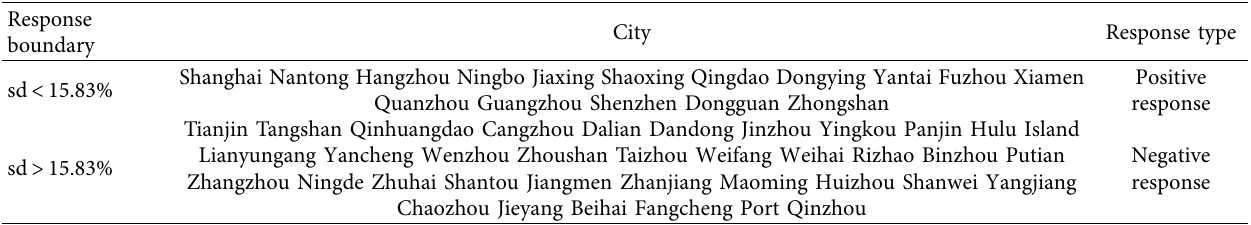
Table 5: Identification of city type by the second threshold regression